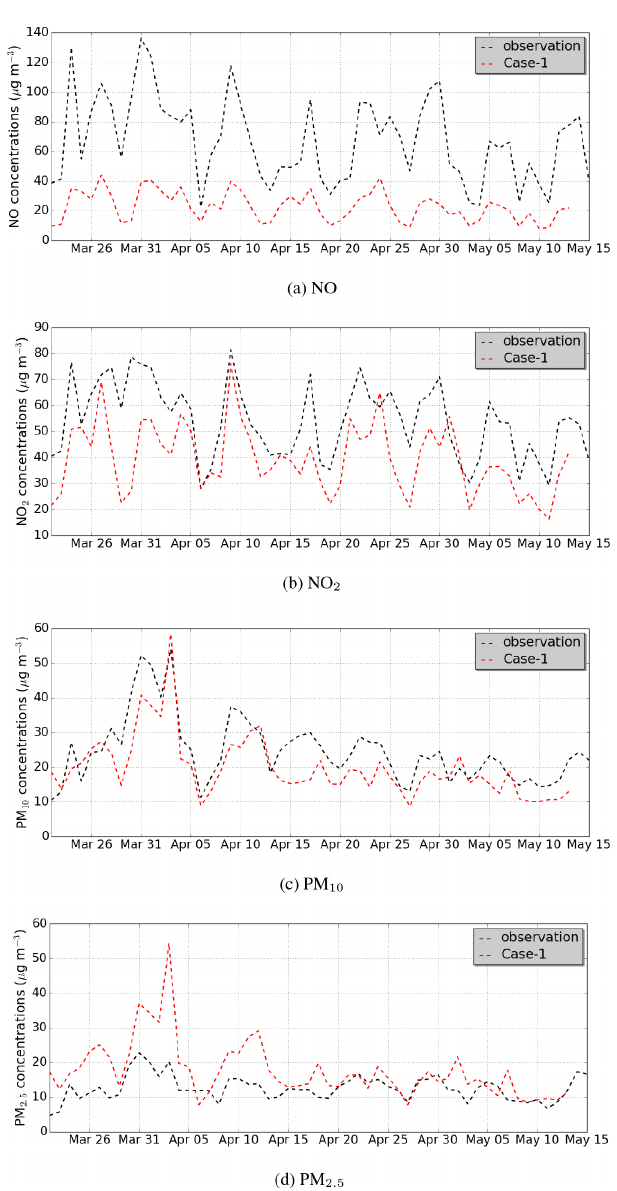
Figure 5. Comparison of daily-averaged concentrations (in µgm − 3 ) in the (reference) Case-1 simulation to the measurements at the monitoring station for (a) NO, (b) NO 2 , (c) PM 10 , and (d) PM 2 . 5 .